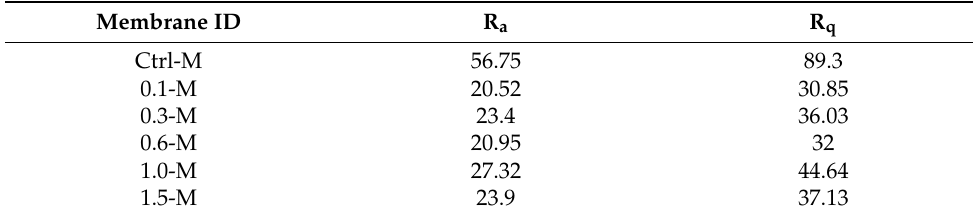
Table 2. Roughness parameters over a 50 × 50 µ m scan size.